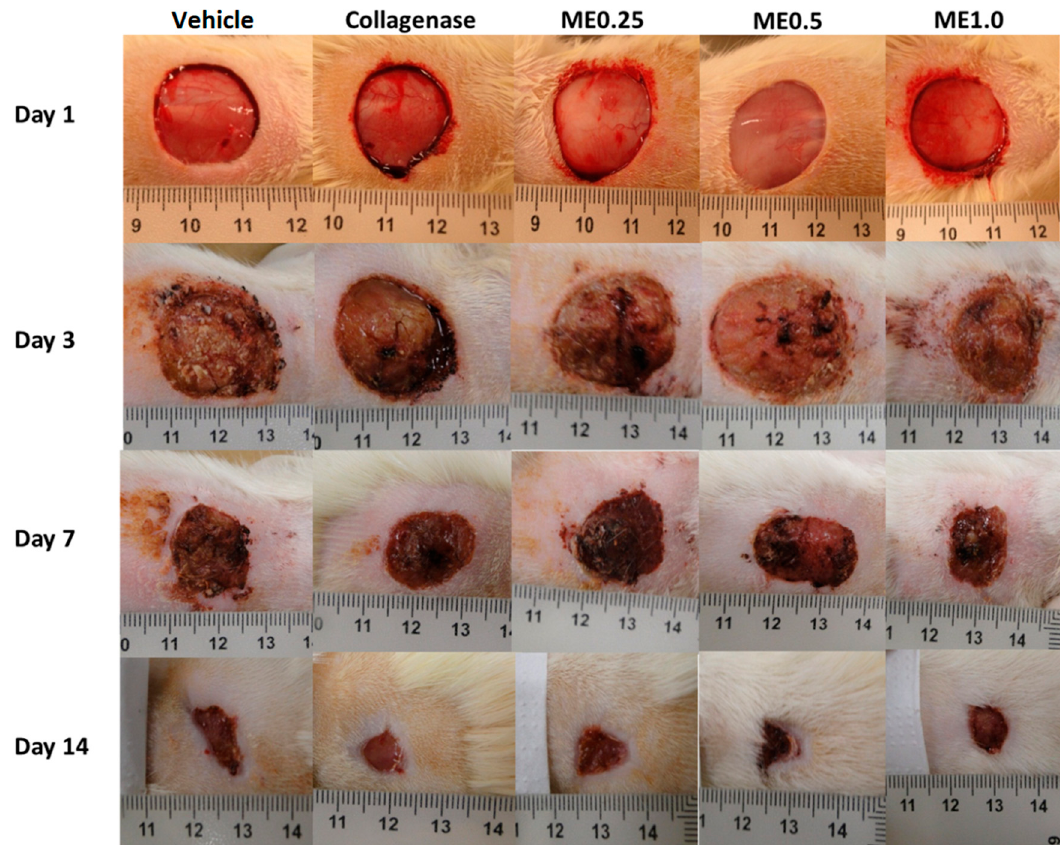
Figure 2. Skin wounds at the moment they were performed and after 3, 7, or 14 days of treatment with vehicle, collagenase cream, ME.025, ME0.5, or ME1.0.